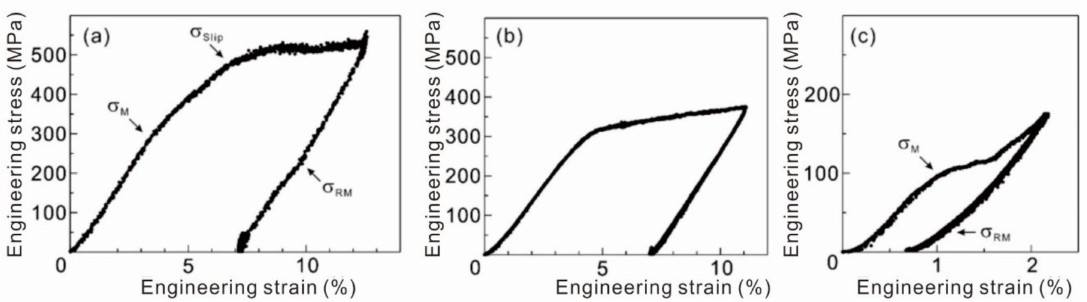
Figure 3. Engineering stress–strain curves of the single crystalline pillars with orientations ( a ) [111], ( b ) [011], and ( c )